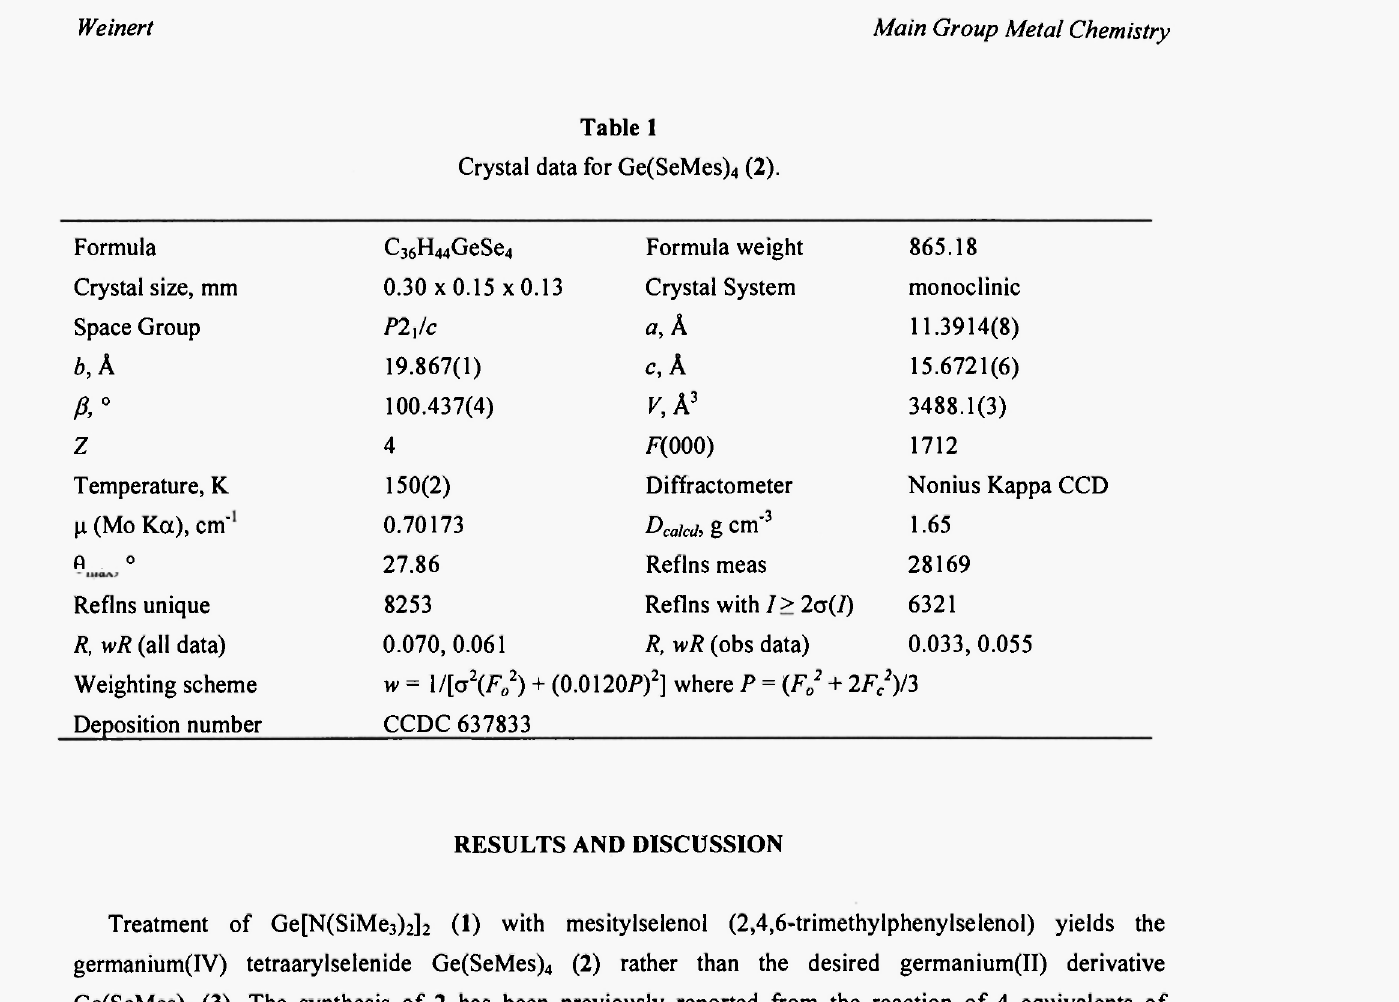
Crystal data for Ge(SeMes) 4